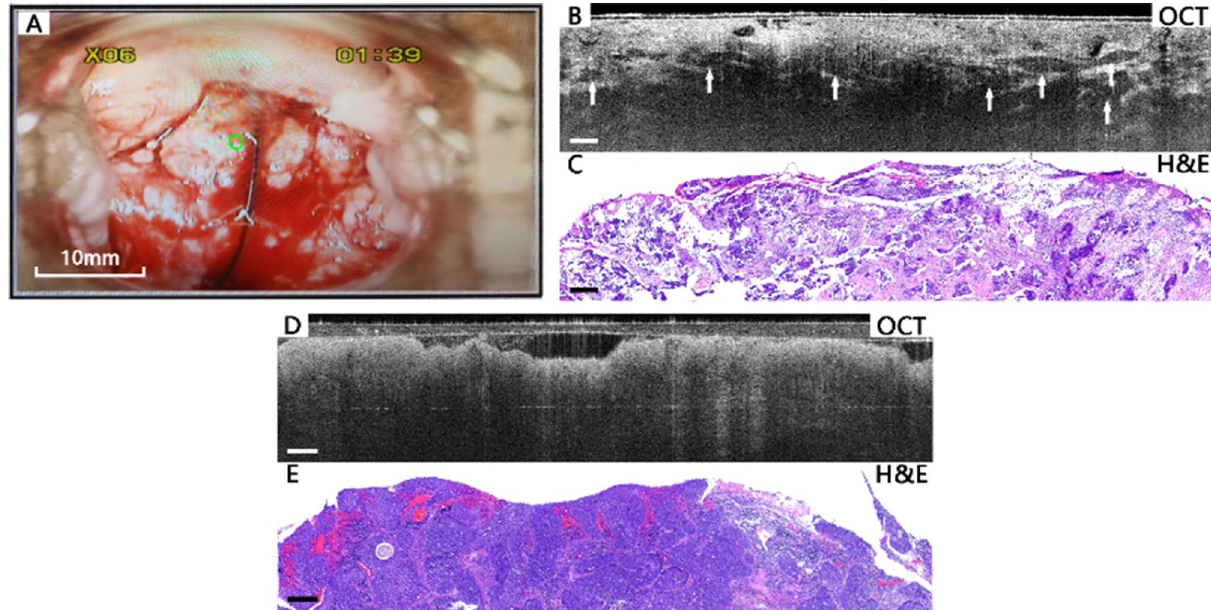
Figure 5. Typical images of cervical cancer tissues. Colposcopy image ( A ), OCT image ( B ), and the corresponding histological image ( C ) of a squamous carcinoma case. In the OCT image ( B ), heterogeneous regions of hypo-scattering nests or clusters (arrows) can be identified. OCT images ( D ) and corresponding H&E histological sections ( E ) of another cancer tissue. In the OCT image ( D ), similar to Fig. 4B, hyper-scattering